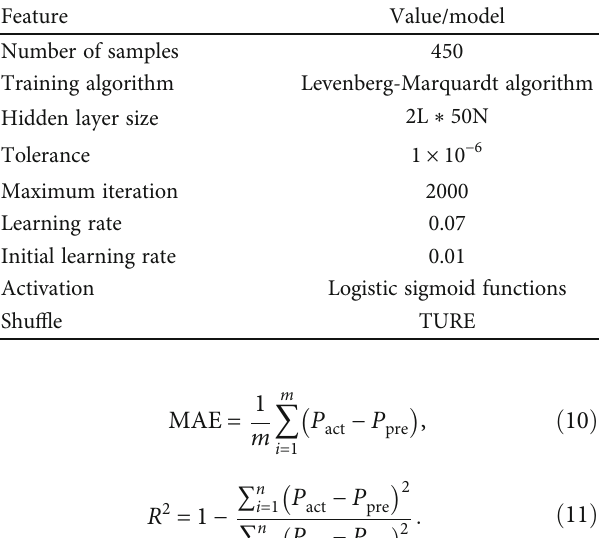
Figure 11: The MSE of an ANN model with di ff erent neurons and hidden layers (using the TASIG transfer function). Table 3: Details of the developed arti fi cial neural network